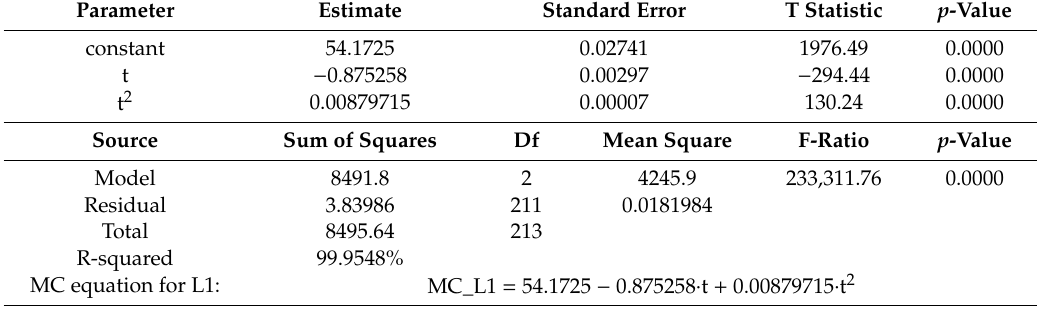
Table 4. Polynomial regression analysis results for moisture content MC as a function of time for laurel